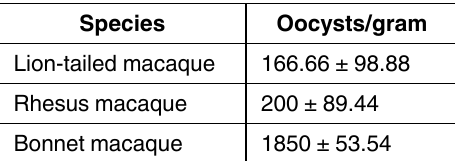
table 2. Oocysts per gram of coccidia in